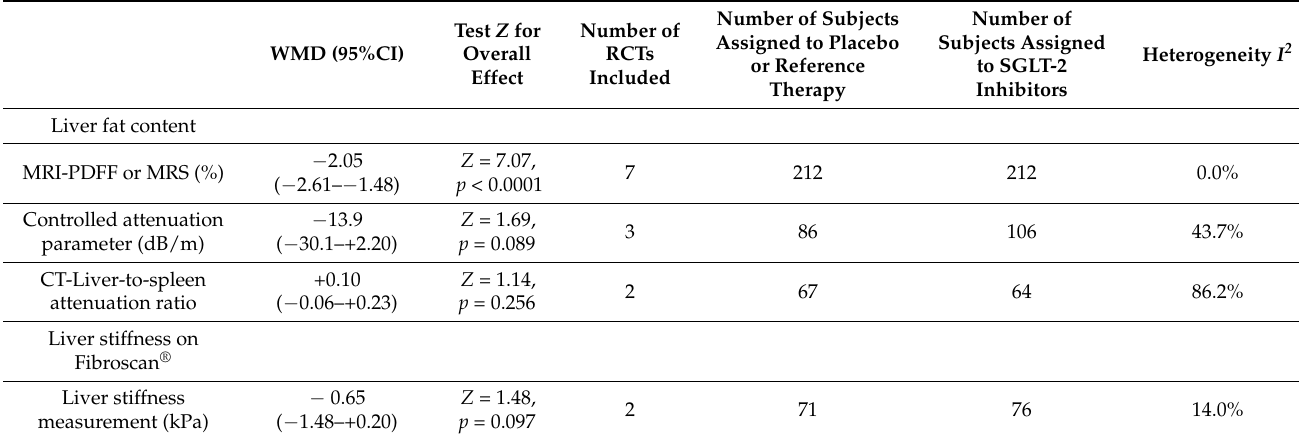
Table 1. Effects of SGLT-2 inhibitors on liver fat content (assessed by magnetic resonance-based techniques (MRI-PDFF or MRS), controlled attenuation parameter (CAP) on Fibroscan ® and computed tomography (CT)), as well as on liver stiffness measurement assessed by vibration-controlled transient elastography (Fibroscan ®